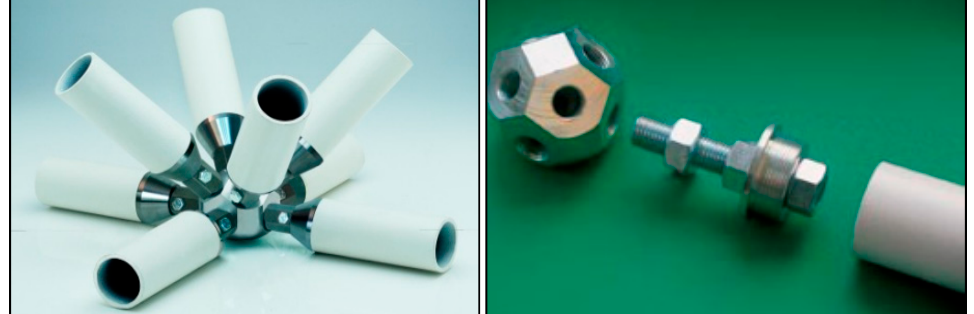
Figure A6. Cubotto node, from [30]. Shoulder Prosthesis